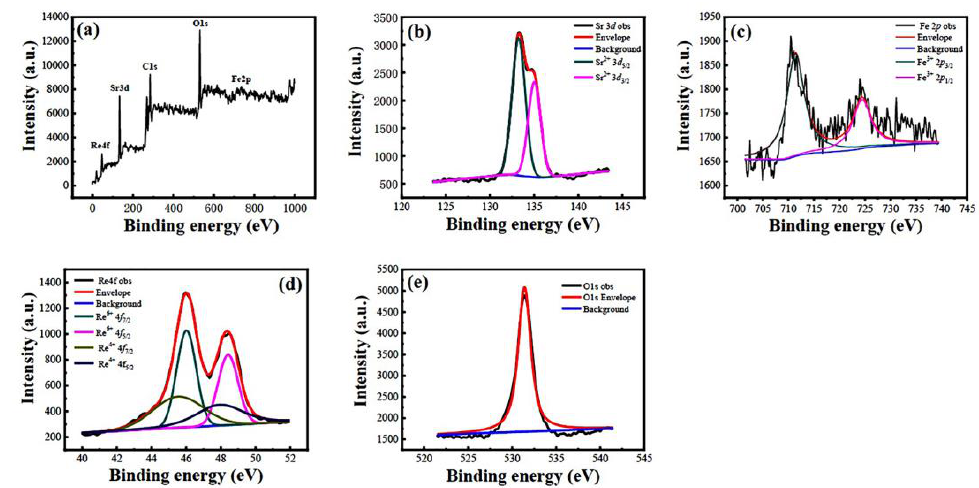
Figure 5. XPS spectra of sample A. ( a ) Survey scan XPS spectrum, ( b – e ) regional scan Sr 3d, Fe 2 p , Re 4 f , and O 1s XPS spectra,